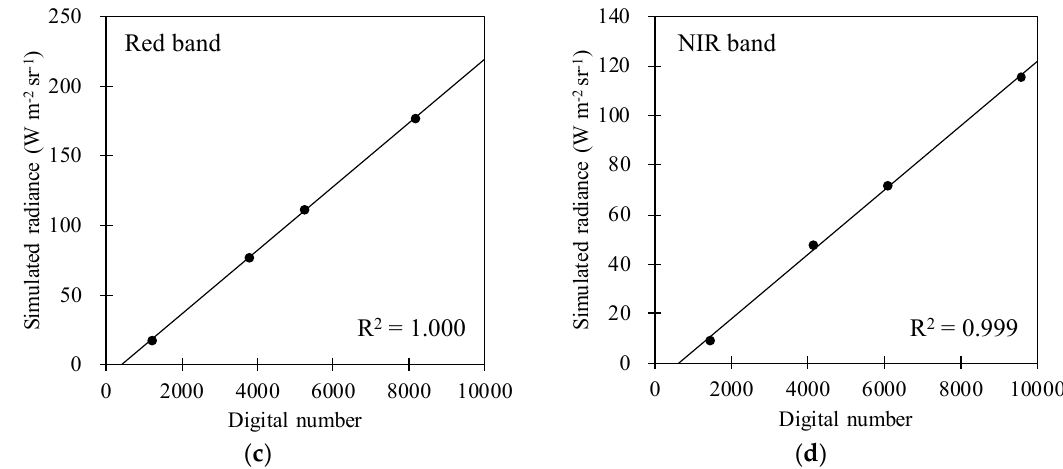
Figure 9. Scatterplots between KOMPSAT-3A DN and simulated TOA radiance for all multispectral bands during the field campaign periods; ( a – d ) represent the blue, green, red, and NIR bands, respectively.